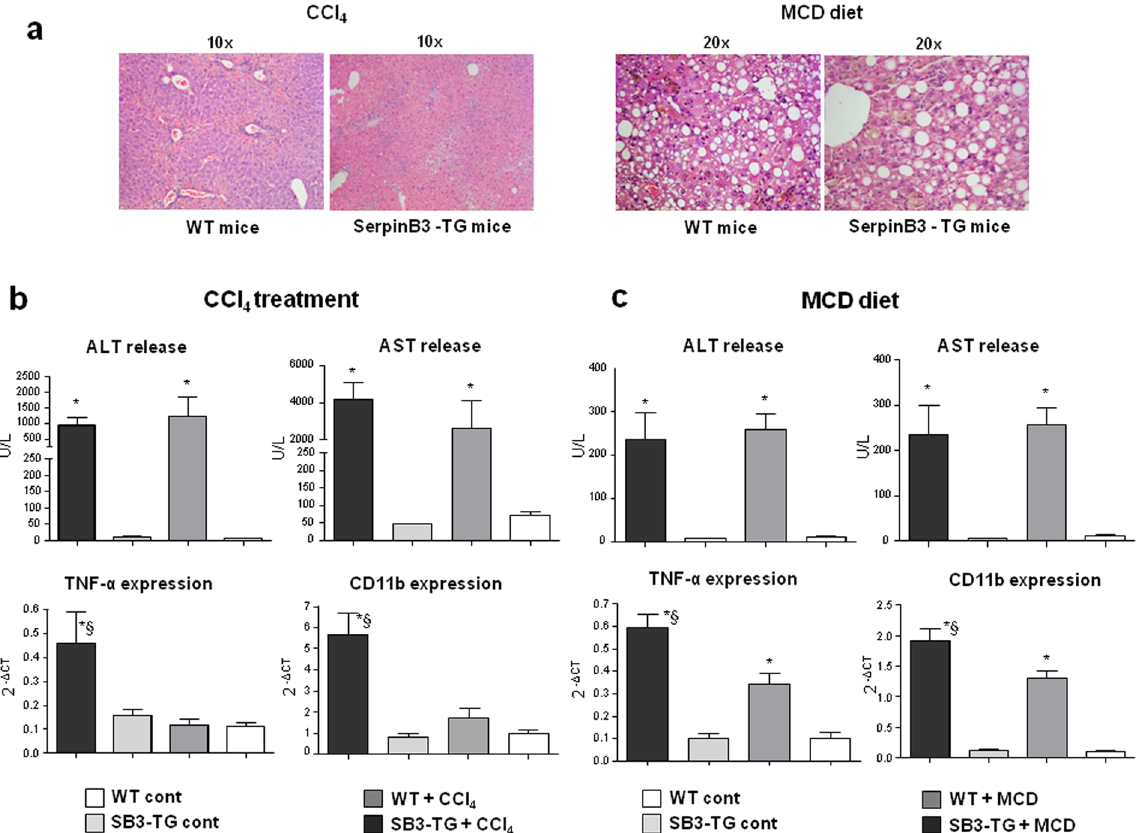
Figure 5. Parenchymal injury and inflammatory markers in SerpinB3 transgenic (SB3-TG) mice and wild type (WT) mice following chronic (10 weeks) CCl 4 administration or 4 weeks feeding with a methionine/ choline deficient (MCD) diet. (a) Liver morphology in mice exposed to CCl 4 or the MCD diet was evaluated by hematoxylin/eosin staining (magnification 10X). Parenchymal injury, estimated by measuring the circulating levels of alanine (ALT) and aspartate (AST) aminotransferases and liver expression of inflammatory markers TNF- α and CD11c, evaluated by quantitative real-time PCR (Q-PCR), are reported in CCl 4 treated mice (b) and in MCD fed mice (c) . Data in graphs are expressed as means ± SD (n = 6 mice for each experimental group) ( * p < 0.01 vs the relative control mice; § p < 0.05 vs WT-mice receiving CCl 4 or the MCD